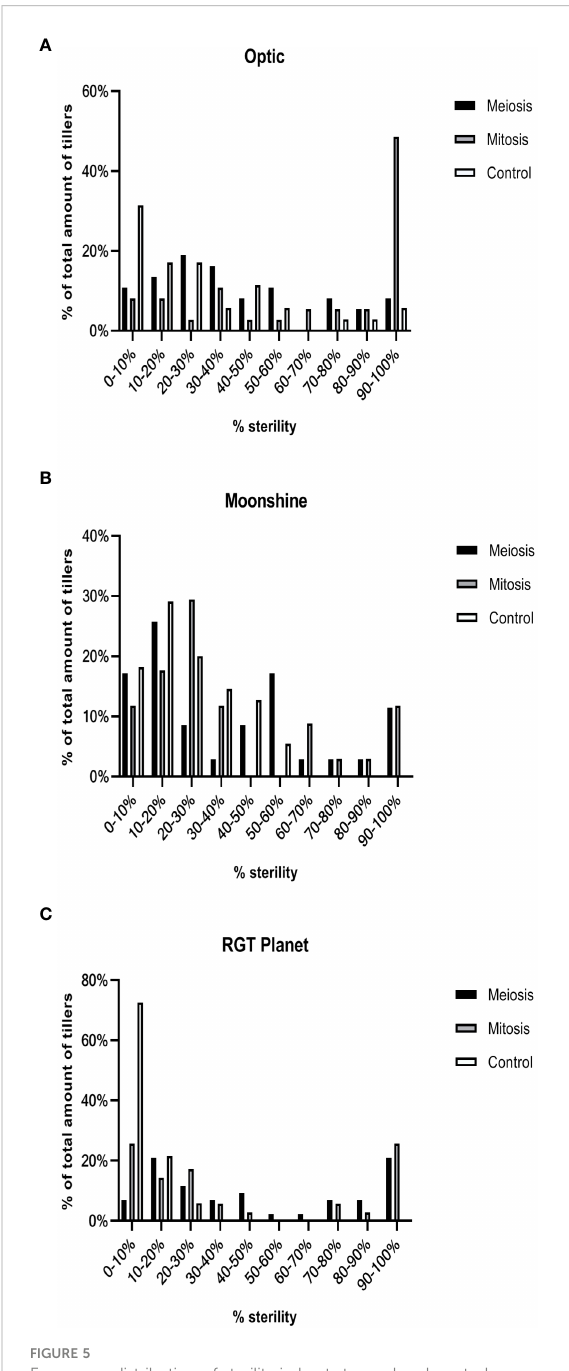
FIGURE 5 Frequency distribution of sterility in heat stressed and control conditions in three European barley varieties. The percentage sterility ( fl orets that did not produce seed) was calculated for all three varieties in control conditions and after meiosis or mitosis I & II heat treatment for all pots (A – C)